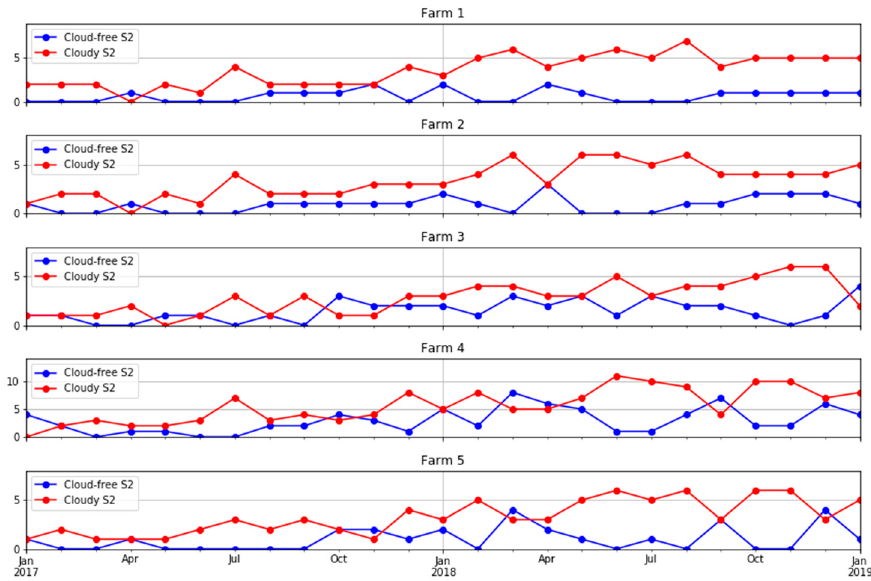
Figure 3. Number of cloud-free and cloud-affected S2 images in each month in the five farms under study.